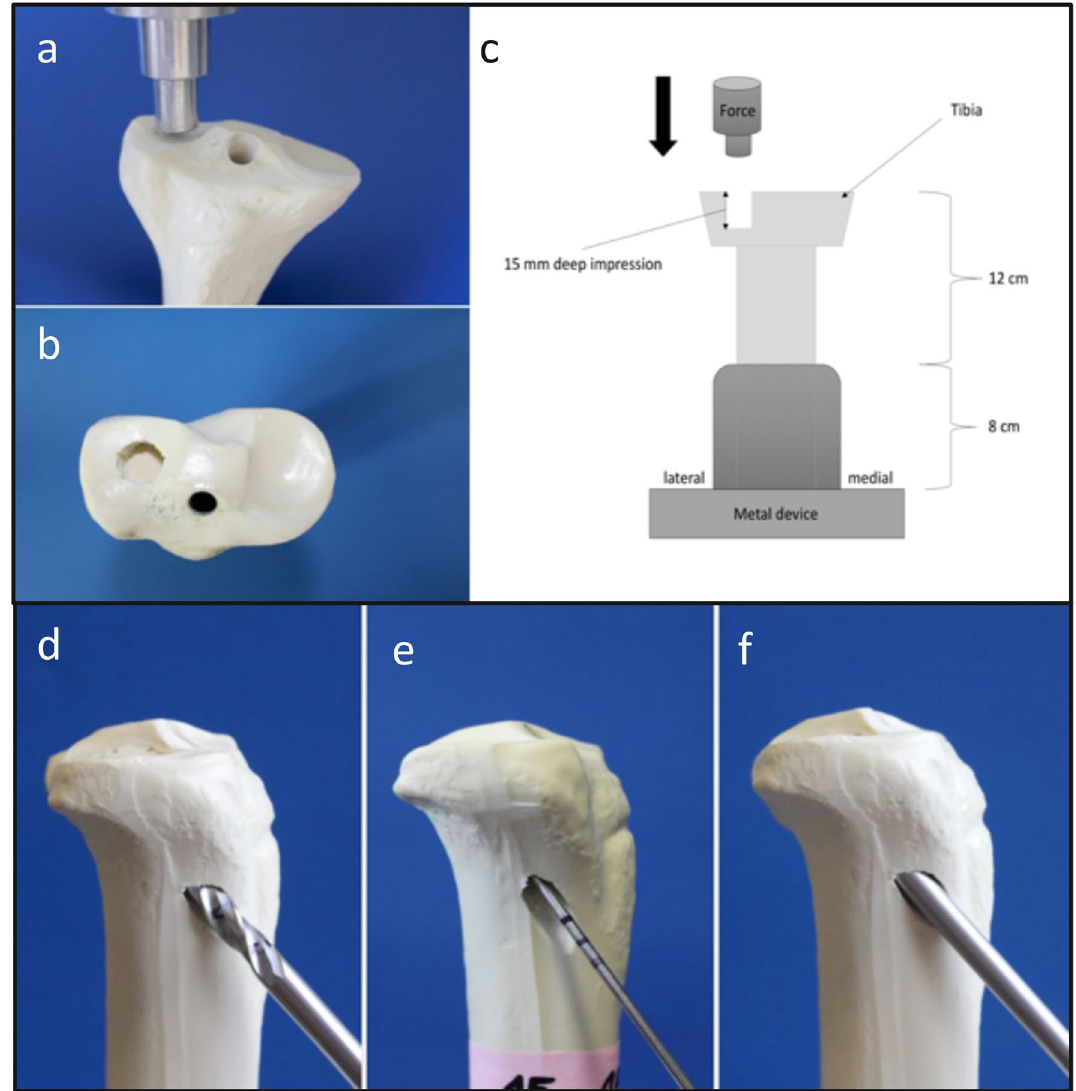
Figure 1. Fracture generation, reduction and test set up are shown. The lateral tibial plateau was loaded axially as demonstrated for fracture generation ( a+b ) and during the biomechanical testing after fixation ( c ). The simulated lateral depression fractures ( a+b ) were reduced anatomically by an approach at the lateral metaphysis ( d ), the depressed articular fracture fragment was detected by a k-wire ( e ) and then elevated by a cannulated ram ( f ). Group 500 N